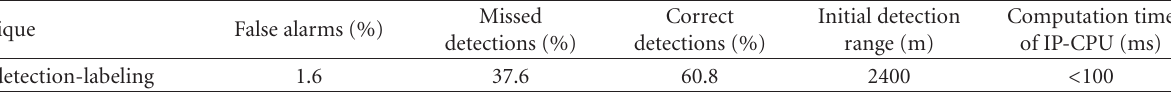
Table 2: Edge detection-labeling performance optimized in the considered frontal encounters.